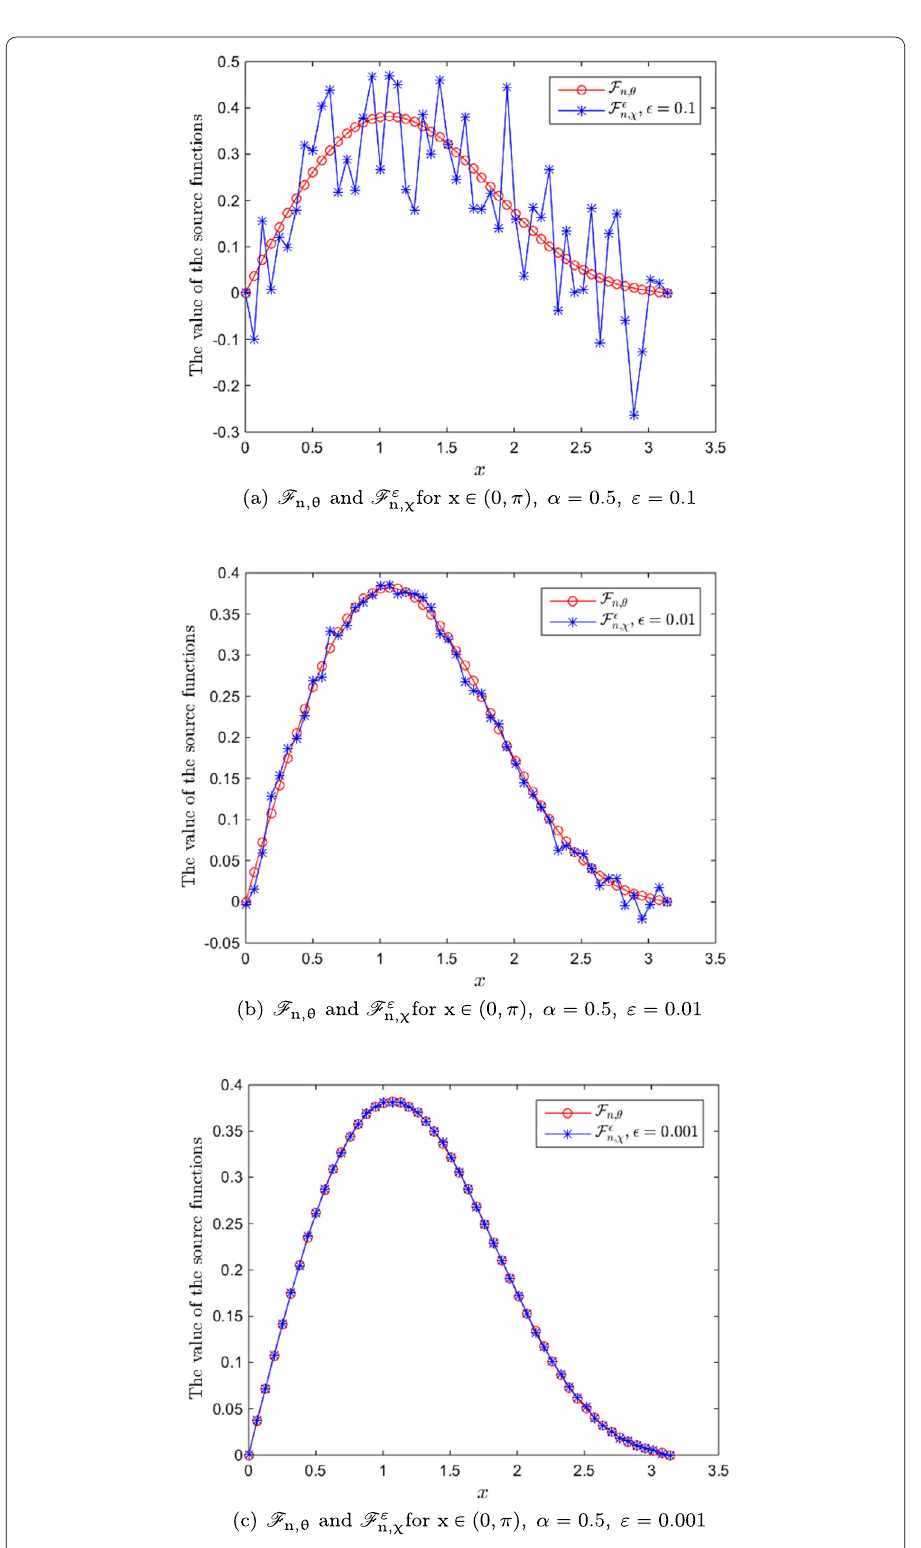
Figure 4 The exact source function F n , θ and the regularized source function F ε n , χ for x ∈ (0, π